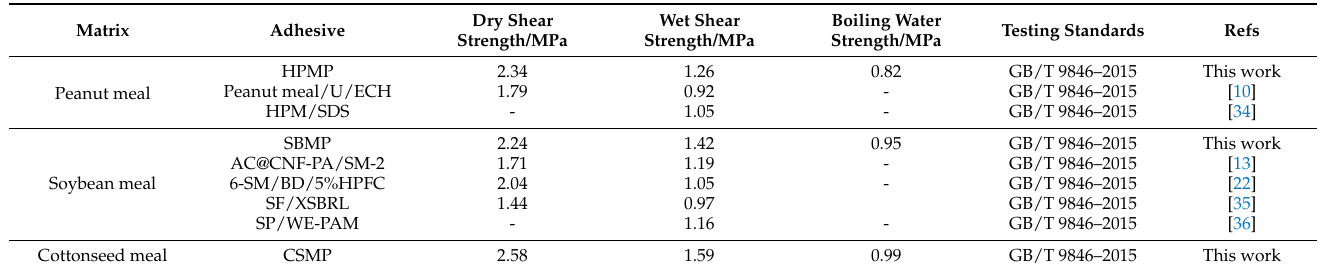
Table 2. Comparison of matrix, the boiling water strength, wet shear strength, and dry shear strength of different